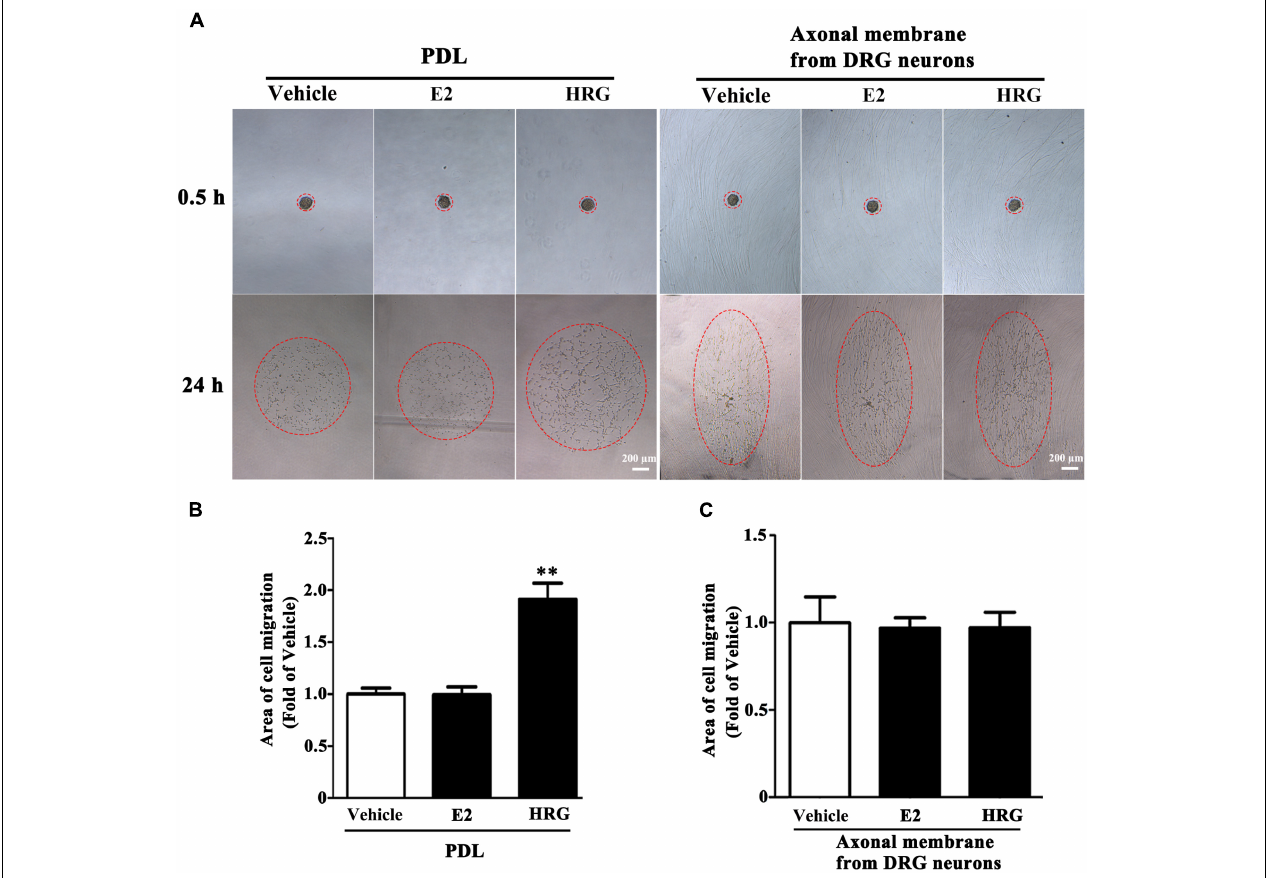
FIGURE 3 | Schwann cell migration was not modulated by E2. Schwann cell reaggregates on fasciculated DRG axons or PDL were incubated with E2 or HRG (Served as positive control), and the area of migration (A) was measured, red dashed circle showed the distance of SC migration, scale bar, 200 µ m. (B,C) Histograms showing that E2 could not stimulate SC migration on both fasciculated DRG axons and PDL, by contrast, HRG significantly increased SC migration from the reaggregates after stimulation with HRG for 24 h on PDL (B) but not on DRG axons (C) . ∗∗ p < 0.01 versus vehicle group. One-way ANOVA, n = 3 cultures per group. All the data are mean ±